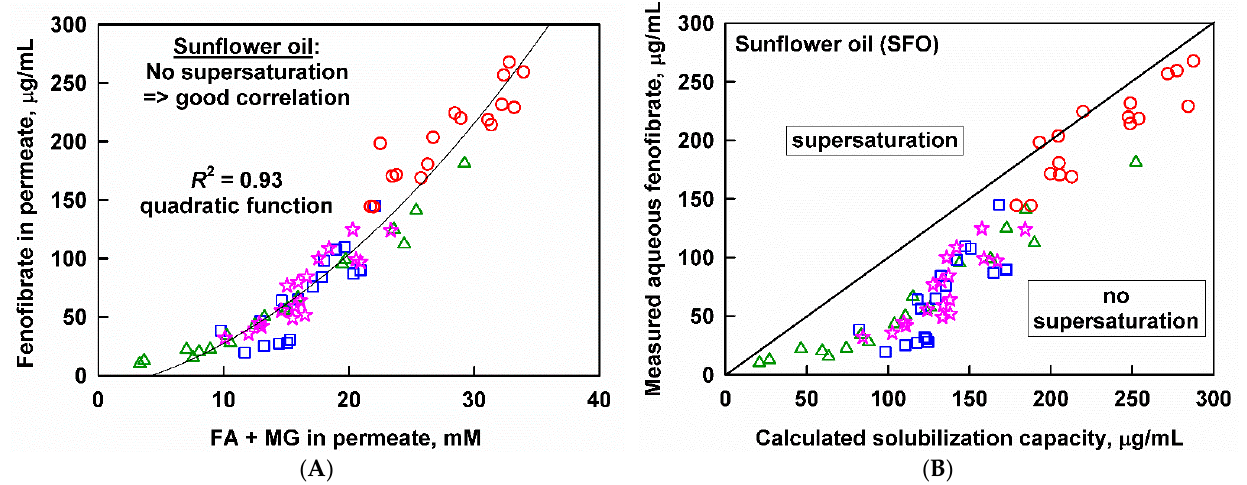
Figure 8. Aqueous fenofibrate as a function of ( A ) the sum of fatty acids (FA) and monoglycerides (MG) measured in the aqueous phase or ( B ) the calculated solubilization capacity, after digestion of SFO emulsions with d 43 = 0.7 µm (10 wt% emulsifier, red circles), d 43 = 2.2 µm (1 wt% emulsifier, blue squares), d 43 = 11.8 µm (10 wt% emulsifier, pink stars) and d 43 = 11.8 µm (1 wt% emulsifier green triangles). Individual (non-averaged) data points are plotted.